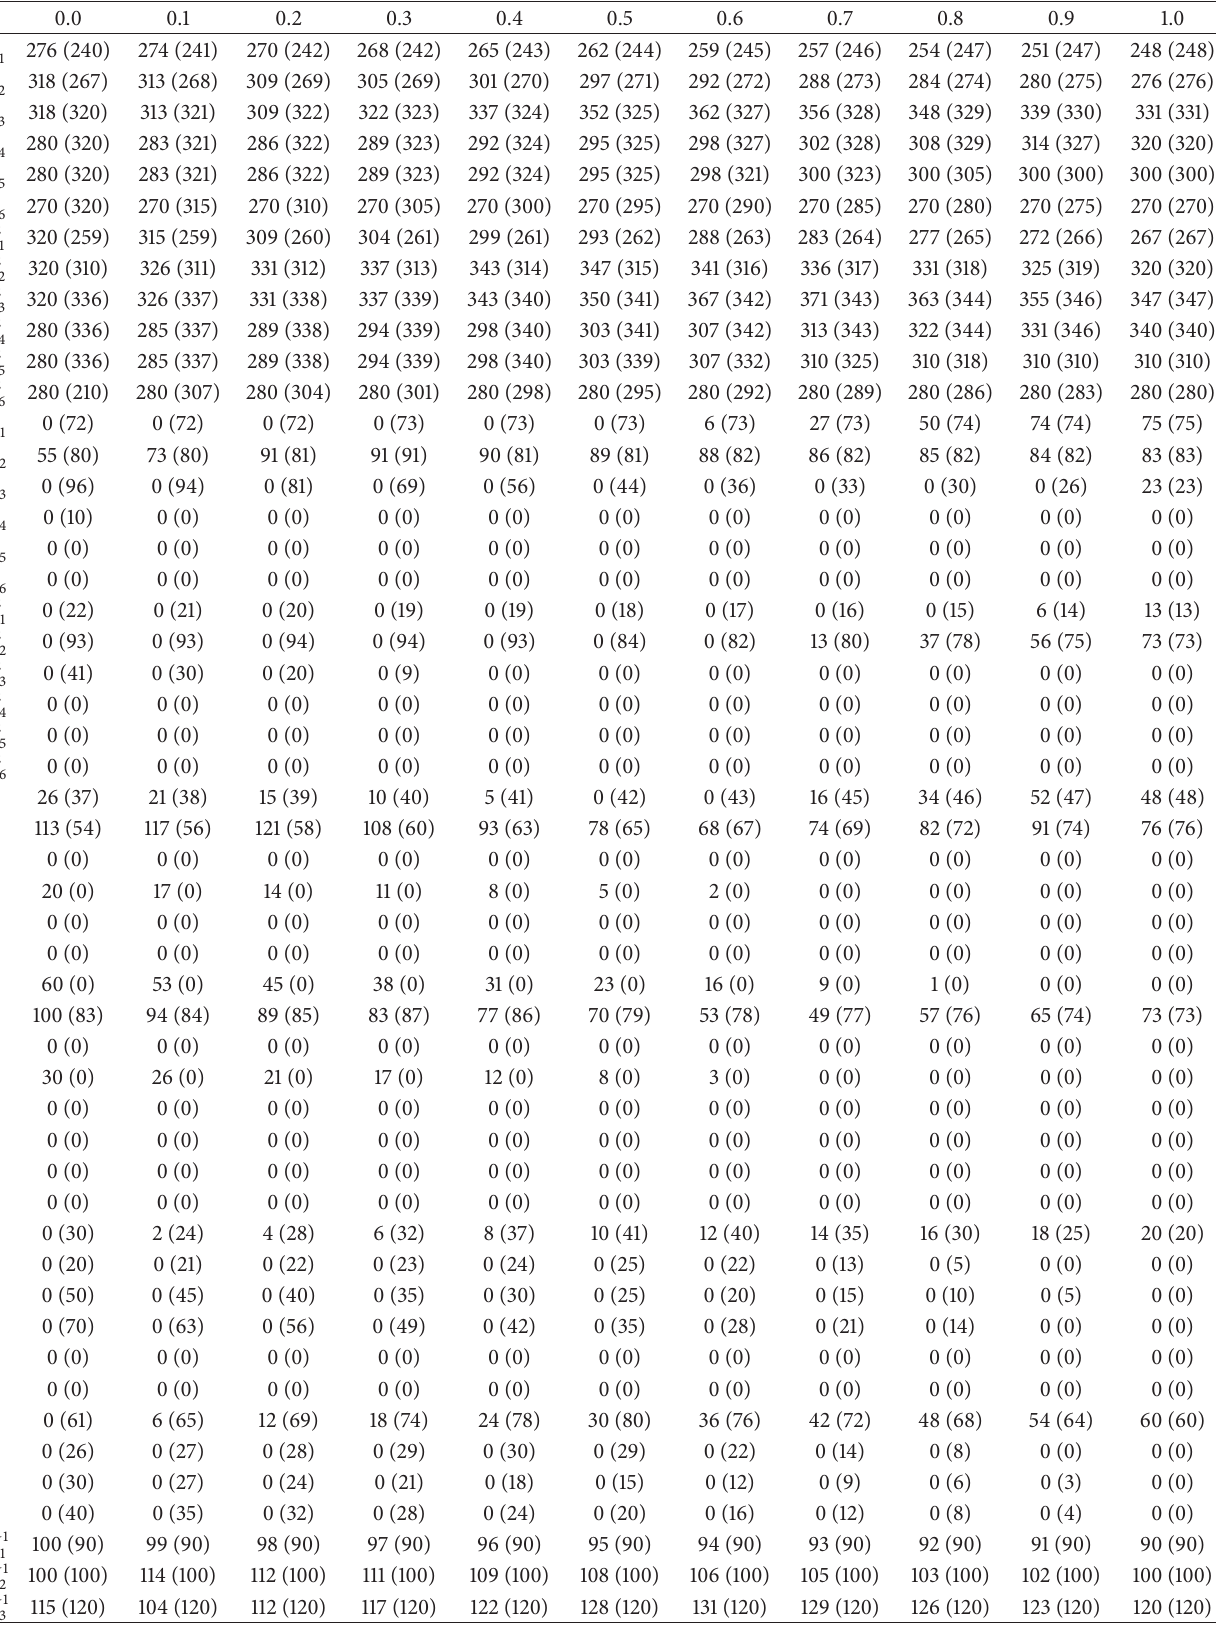
Table 10: Optimal aggregate production plans corresponding to lower and up per (in parentheses) bounds at 11 𝛼 values. 𝛼